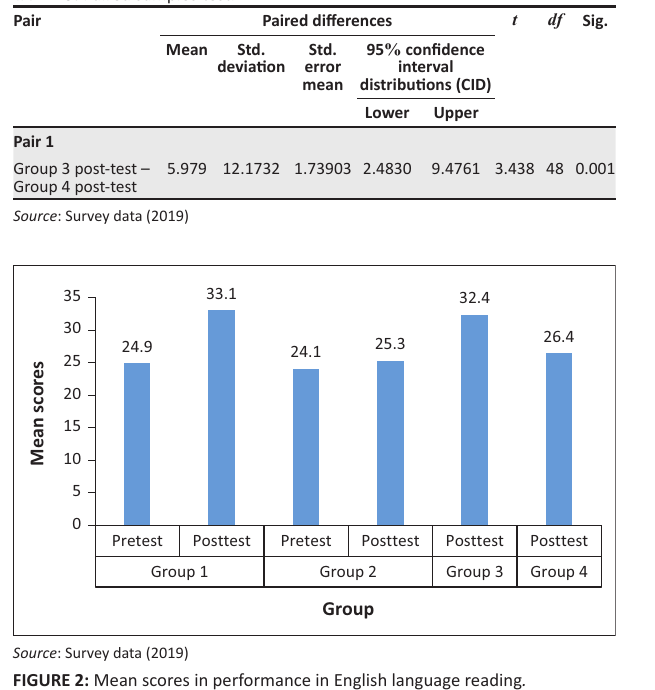
FIGURE 2: Mean scores in performance in English language reading